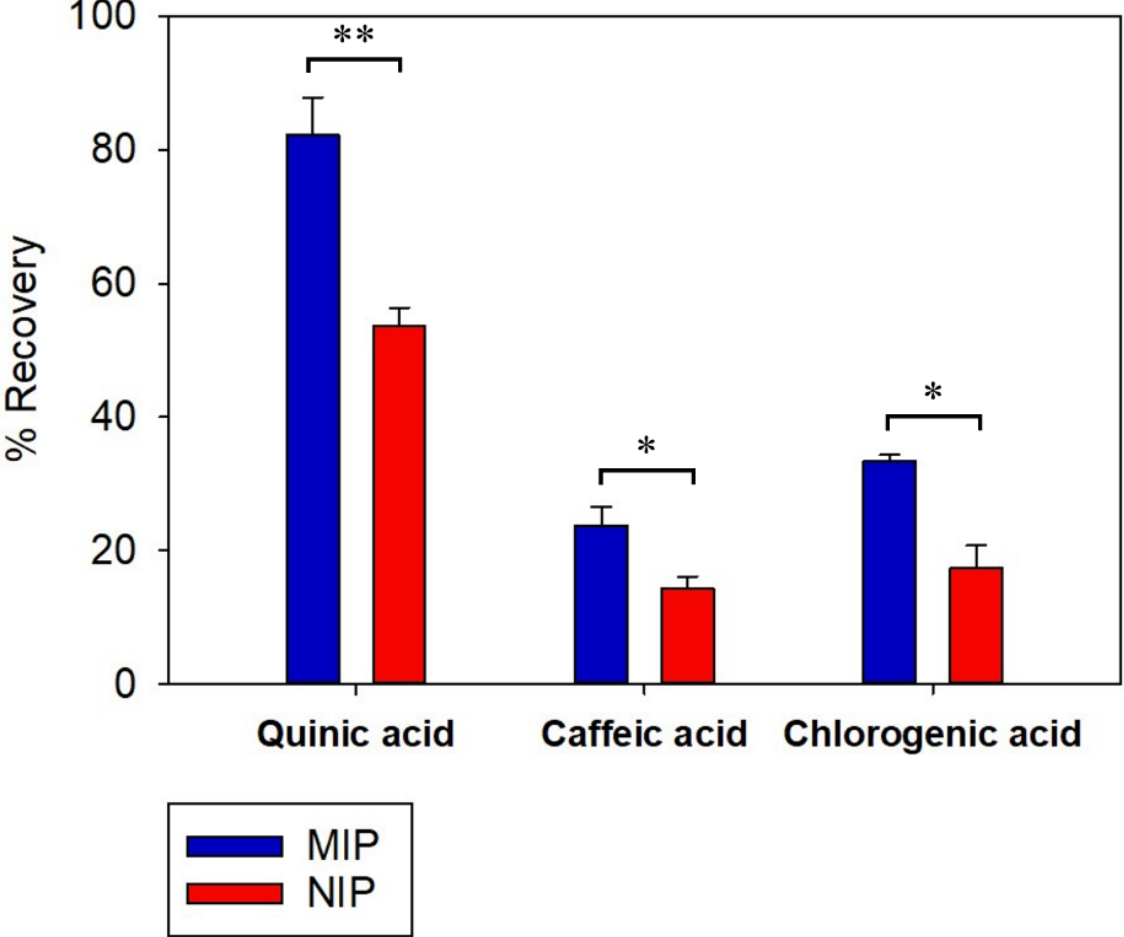
Figure 8. Recovery percentages of QA, CA and CLA upon loading an equimolar mixture of the three compounds to MISPE and NISPE, ( n = 3), * indicates p value ≤ 0.05 and ** indicates p value ≤ 0.01.